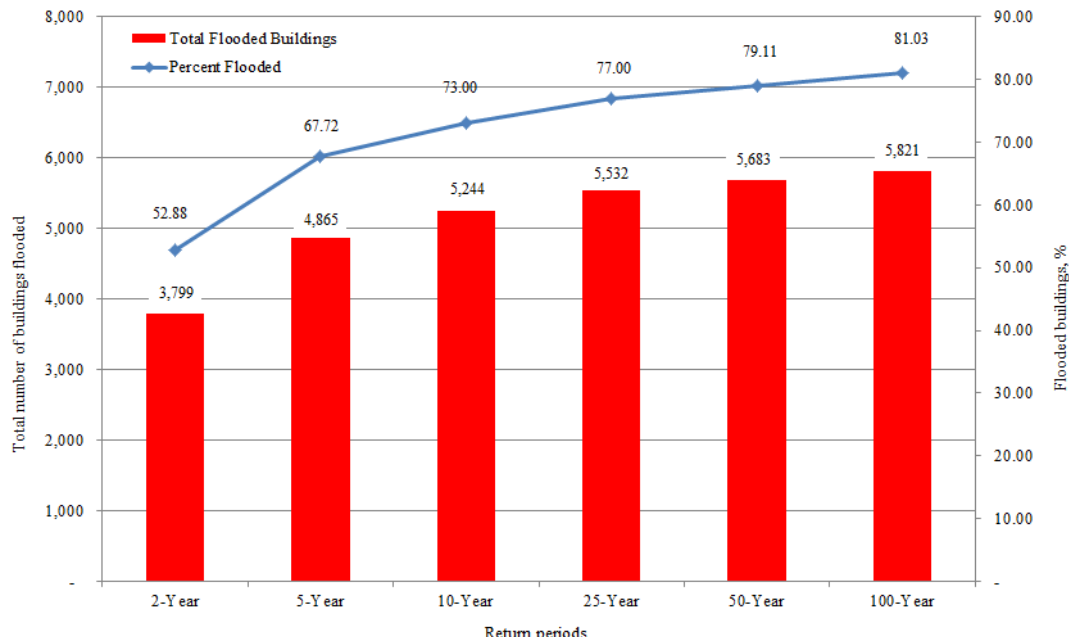
Fig. 11: Total number of flooded buildings and percentage in different return periods